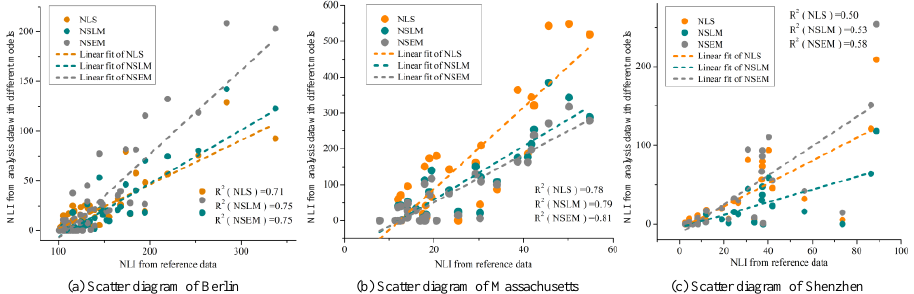
Figure 5. Scatter diagrams and R 2 values of estimated nighttime light intensity (NLI) data and reference data in three study areas for the three regression models.